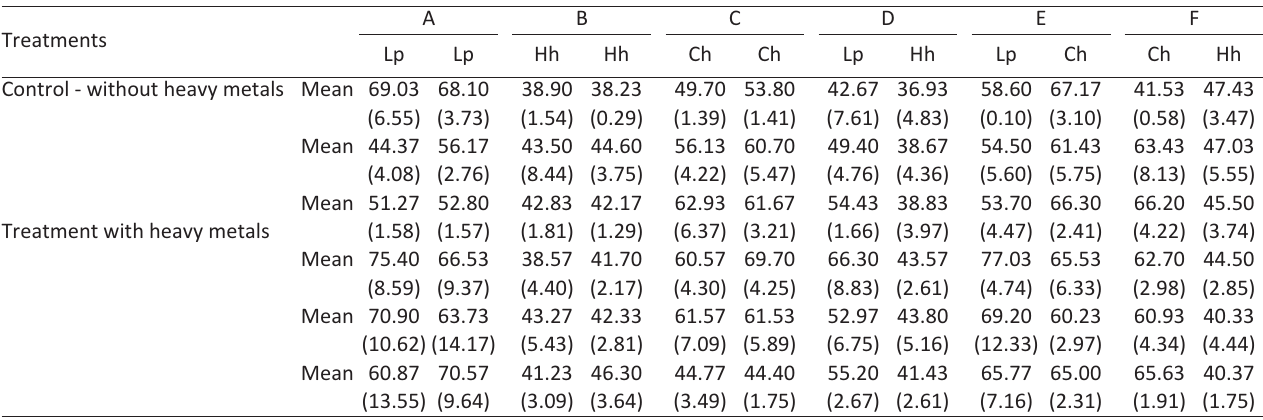
Lp= Lonicera pileata , Hh= Hypericum ‘Hidcote’, Ch= Cotoneaster horizontalis . Standard deviation in brackets. SPAD readings were recorded for 3 positions on each leaf and for 3 different leaves on a single shrub. Treatments were at 2 plants per pot, each pot contained 2 plants of the same species (column A, B and C) and plant mix (2 species, column D, E and